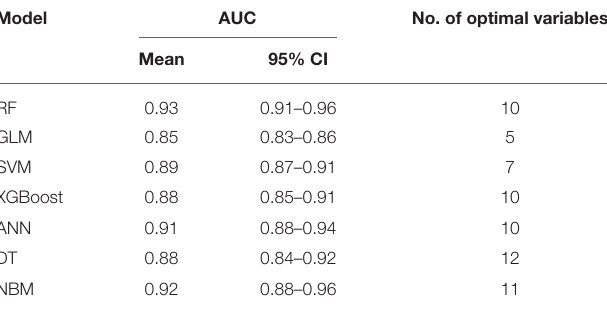
TABLE 4 | The predictive performance of candidate models based on maching learning algorithm.